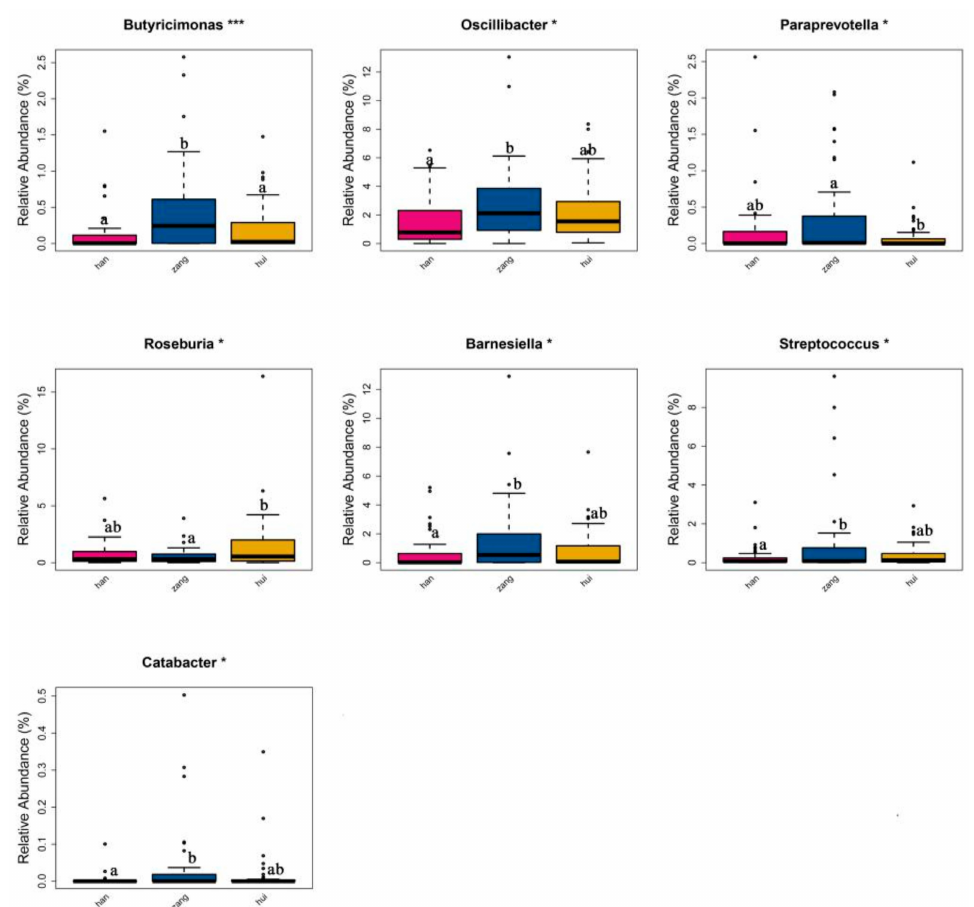
Figure2. Boxplotsoftherelativeabundanceofsignificantlydi ff erentgeneraintheHan, Tibetan, andHui populations. Boxes represent the interquartile range, and the center line indicates the median. Whiskers denote the lowest and highest values (ANOVA). a,b indicate significant di ff erences between